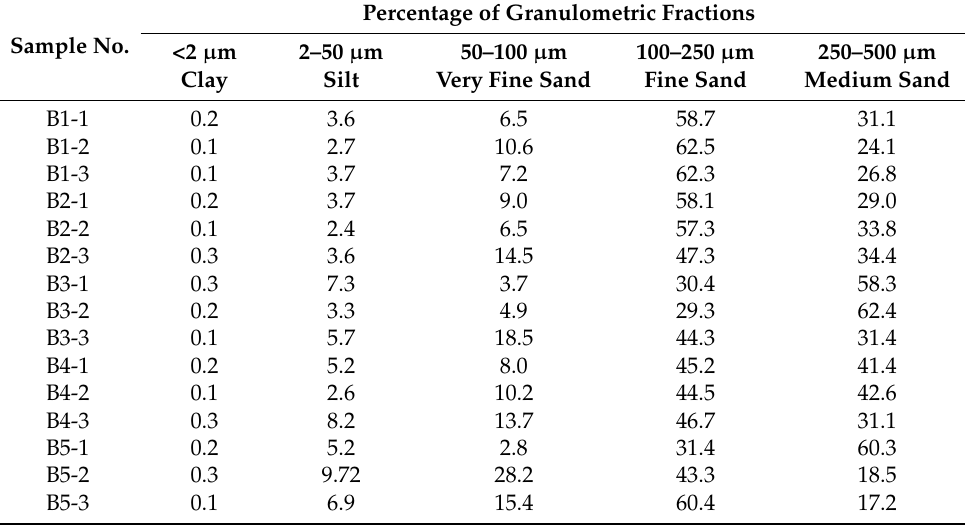
Table 4. Granulometric composition of bottom